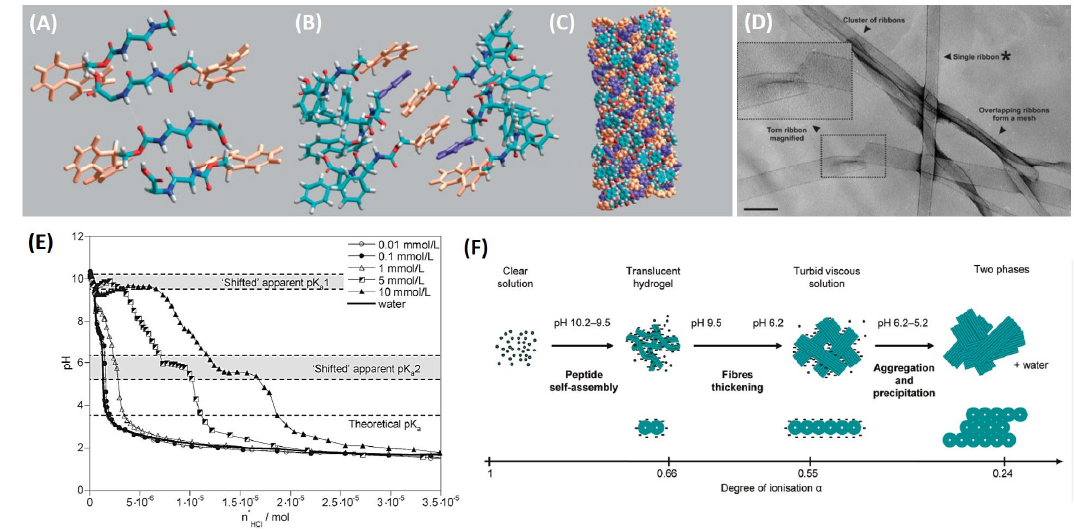
Figure 2. Structural model of Fmoc-FF peptides. ( A ) Dipeptide copies are arranged into β-sheet with an antiparallel orientation of β-strands. ( B ) π-stacked pairs due to the interlocking of fluorenyl groups from alternate β-sheets. ( C ) The final model obtained by energy minimization. In the model Fmoc and the phenyl groups are coloured in orange and in purple, respectively. ( D ) Transmission electron microscopy of Fmoc-FF xerogel (scale bar = 500 Å); the ribbon asterixed by authors was selected for other morphological analysis. ( E ) Titration curves of water and Fmoc-FF samples at different peptide concentrations (0.01, 0.1, 1, 5, and 10 mmol/L). ( F ) Mechanism proposed to explain